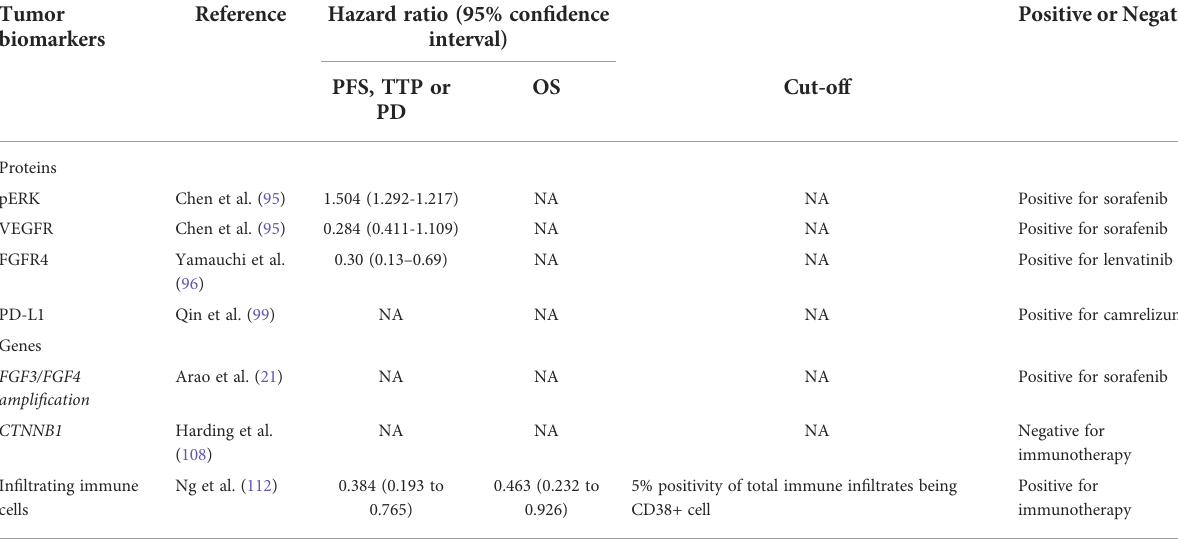
TABLE 3 Predictive biomarkers within tumors for the systemic treatment of hepatocellular carcinoma. Tumor